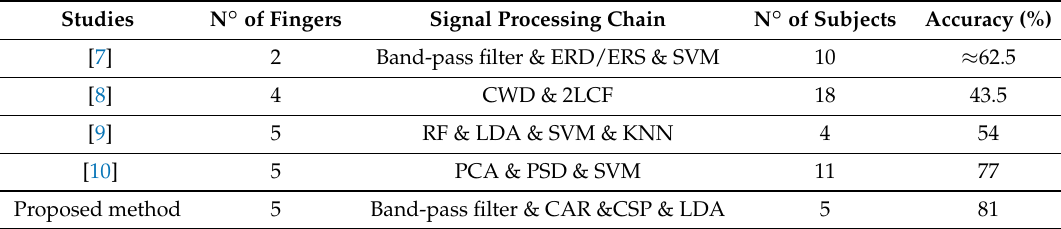
Table 2. Comparison of the proposed method system with other EEG finger decoding